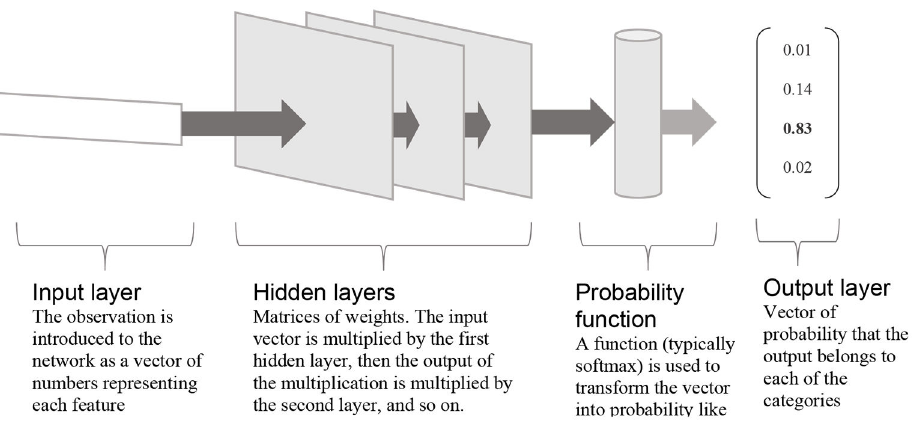
Figure 1. Example of an artificial neural